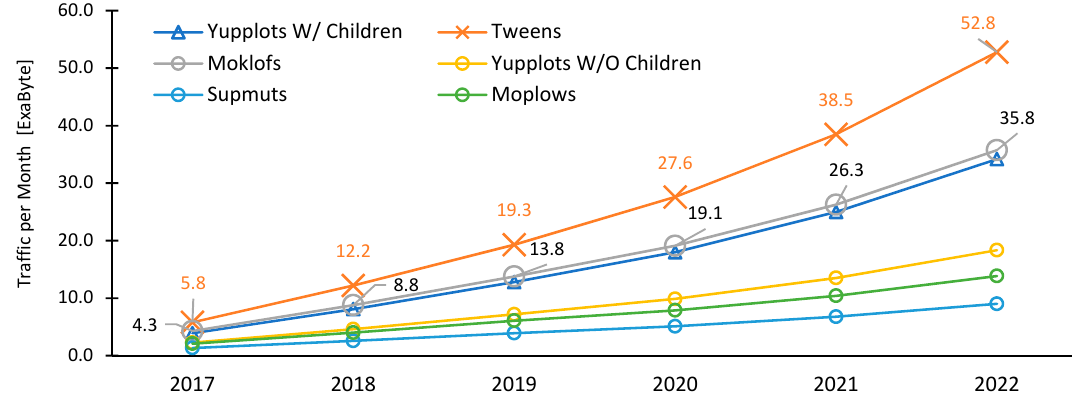
Figure 16. Traffic per month for all six clusters.